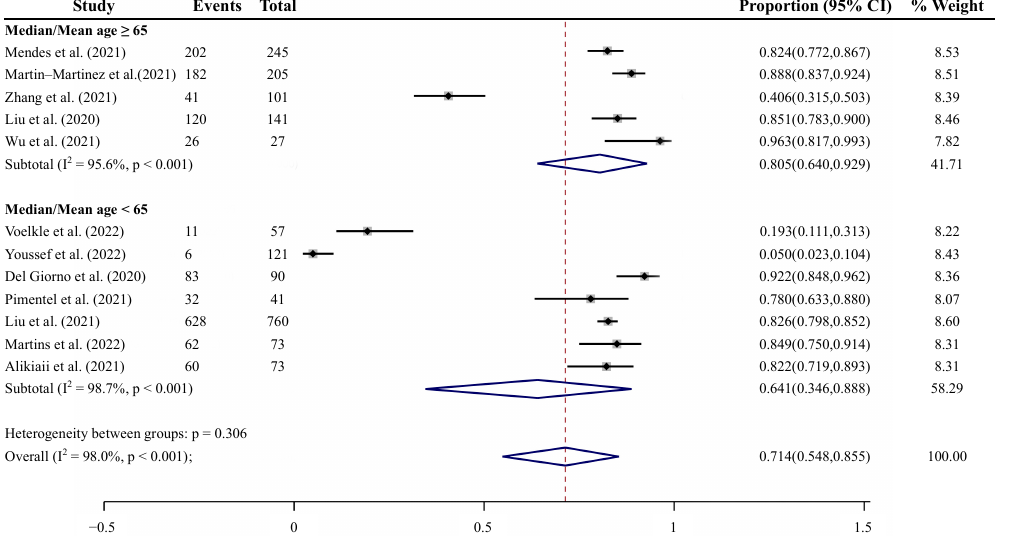
Figure 5. Subgroup Analysis of the Prevalence of Malnutrition in COVID-19 Patients by World Bank country classifications by income level [36–52]. High-income economies: Switzerland, Spain, Italy, and Poland; Upper-middle-income economies: China and Brazil; Lower-middle-income economies: Philippines, Egypt, and Iran.